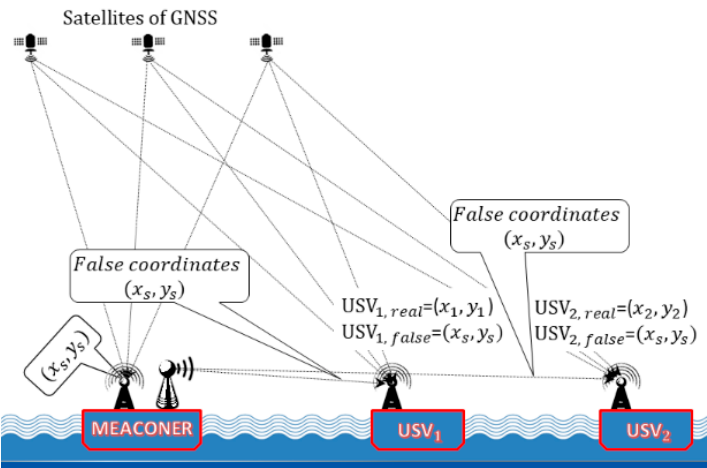
Figure 7. The basic GNSS meaconing scheme of USVs: at some point in time, the meaconer determines its position ( x s , y s ) , introducing some delays into each of the satellite channels, and transmitting the false position ( x s , y s ) on the same